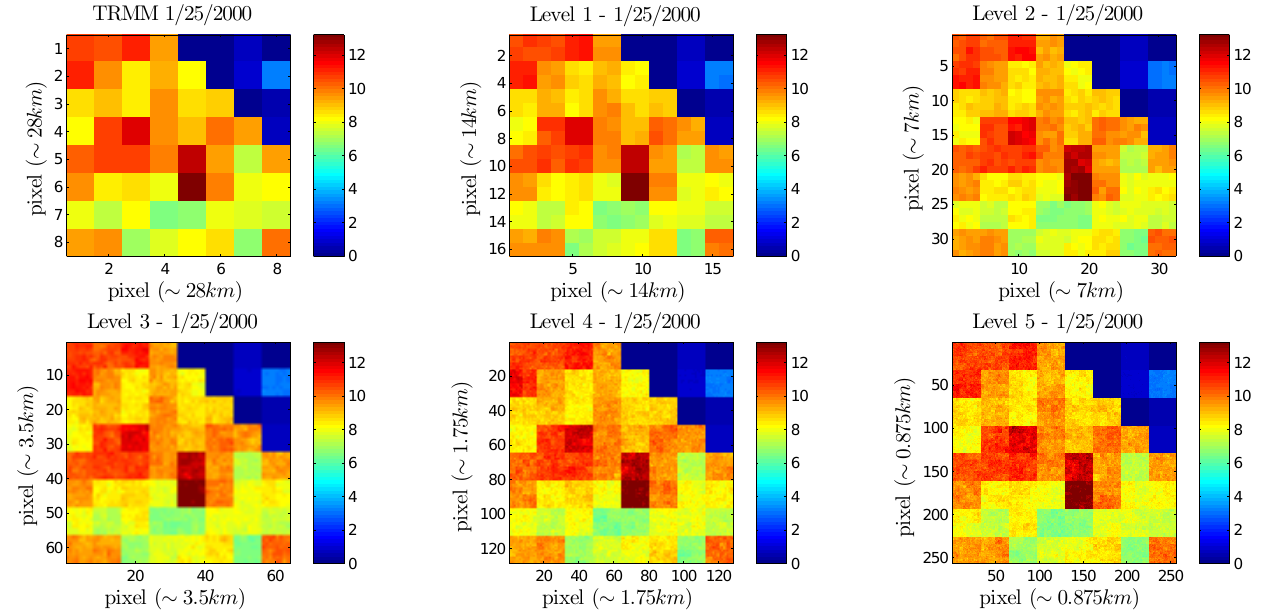
Figure 11. Downscaling for TRMM snapshot on 25 January 2000 for λ n = 14, 7, 3.5, 1.75, and 0.875 (km).